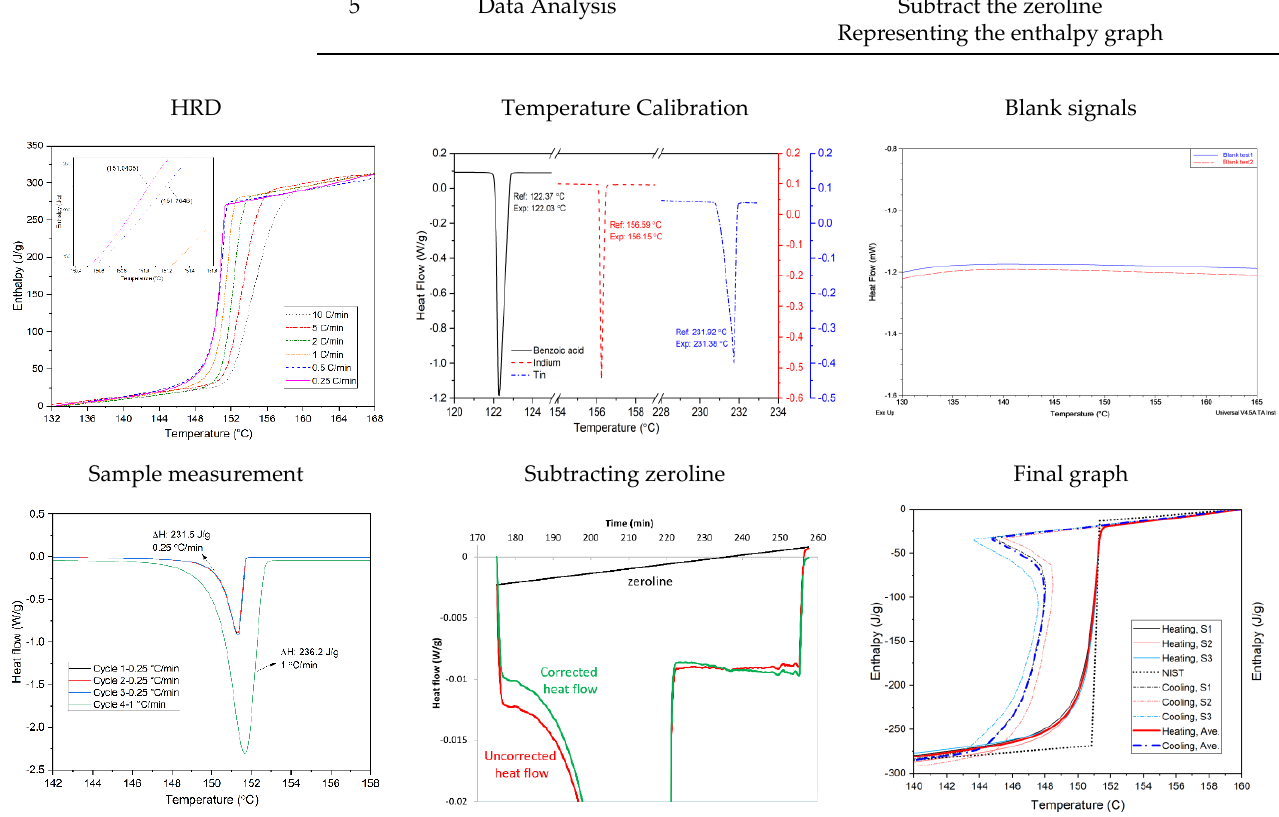
Figure 12. Schematic of the IEA method using personal data with adipic acid (personal data).